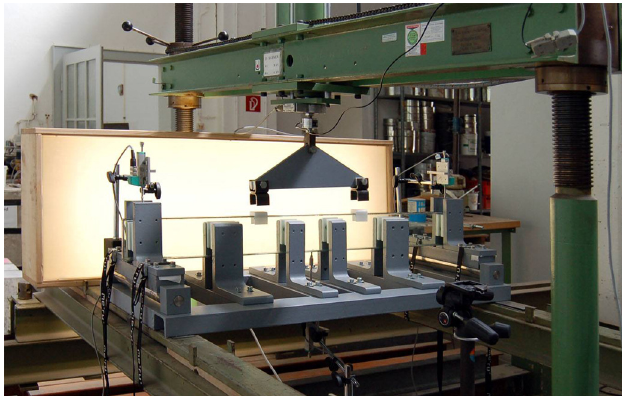
Figure 1: Experimental setup of four-point bending